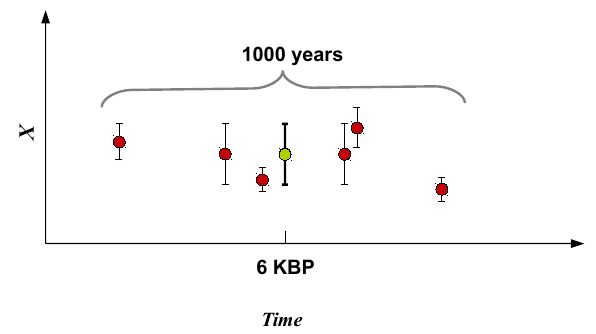
Figure 13. Schematic showing the weights for observations with respect to their standard error. A time window of 1000 years is cho- sen. The red dots represent the proxies in the 1000-year time win- dow and the green dot represents the weighted mean.